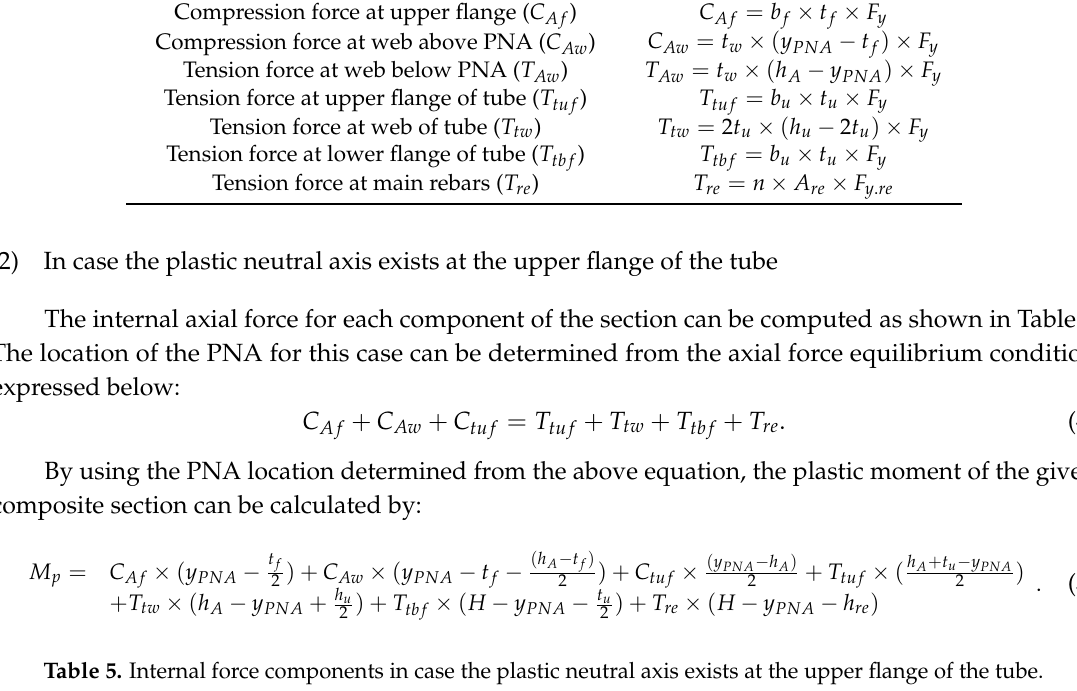
Table 5. Internal force components in case the plastic neutral axis exists at the upper flange of the